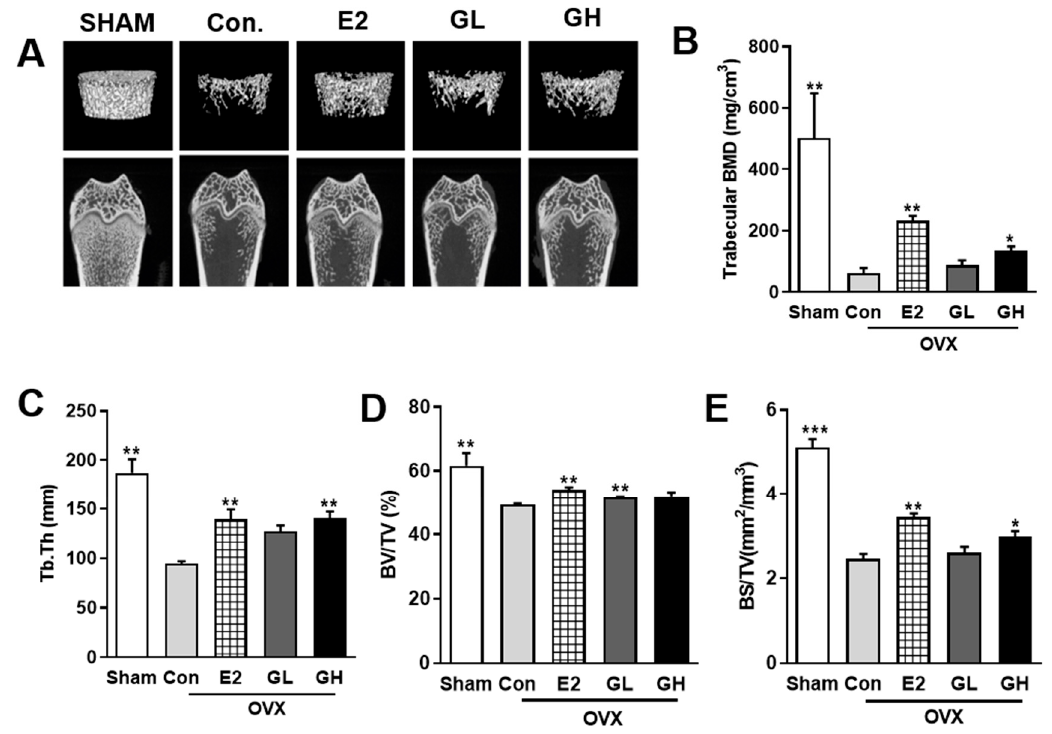
Figure 3. E ff ect of GTE supplementation on bone loss in OVX rats. ( A ) Representative two- and three-dimensional micro-CT images of trabecular bones in the distal femurs of rats from each group. ( B ) Measurement of trabecular bone mass density (BMD) in the distal femurs. Measurement of the trabecular morphometric parameters of trabecular thickness (Tb.Th) ( C ), bone volume / total volume (BV / TV) ( D ), and bone surface / total volume (BS / TV) ( E ) in the distal femurs. Results are expressed as means ± SEM. *** p < 0.001, ** p < 0.01, * p < 0.05, significantly di ff erent from Con.